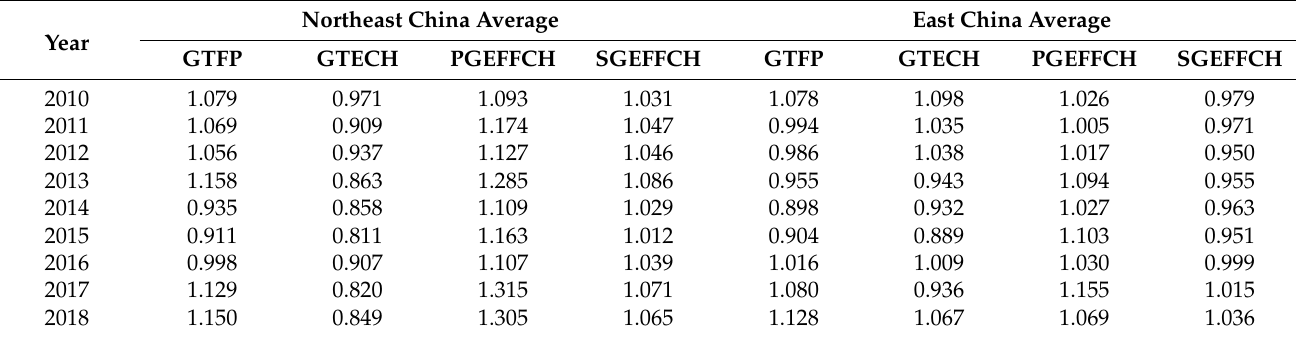
Table 4. Regional average values of GTFP and its